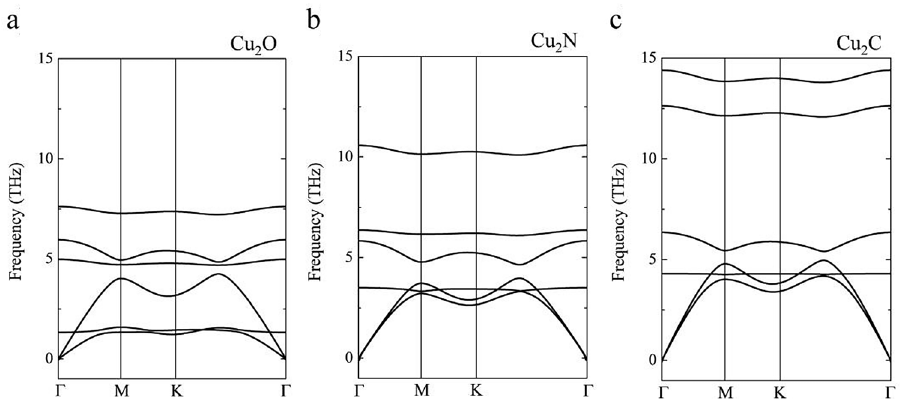
Figure 3. Phonon dispersion for the Cu-based MXene ( a ) Cu 2 O, ( b ) Cu 2 N, and ( c ) Cu 2 C.